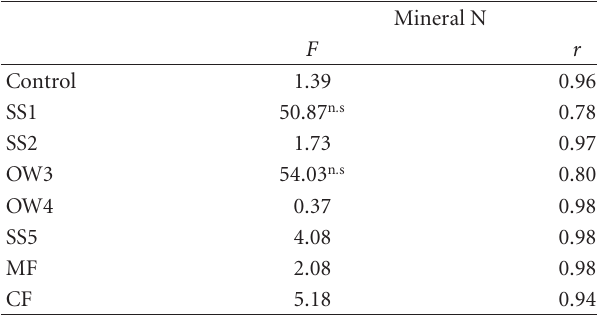
Table 4: F -values used for evaluation of LOFIT in the laboratory incubation experiment, and the correlation coe ffi cient, r , between simulated and observed values. n.s = not significant at 10%